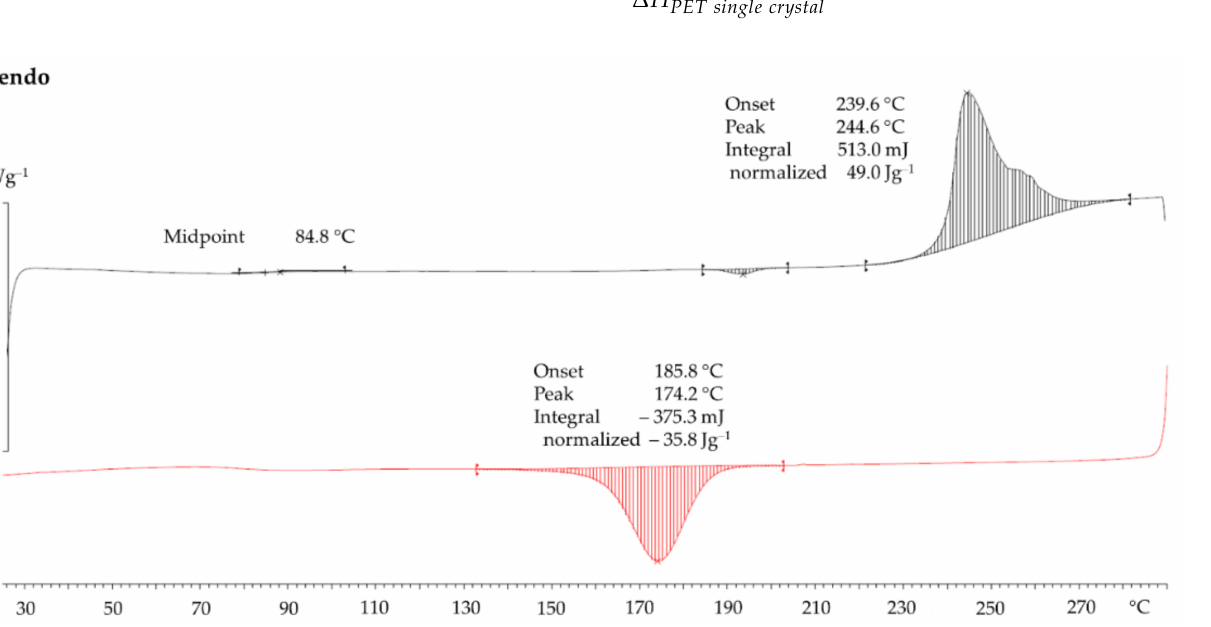
Figure 4. DSC of sieved PET powder and HSS PET bar. Top curve is melting (endothermic) and bottom curve is cooling (exothermic). The clear separation of the melting and crystallisation peaks in the powder is advantageous for PBF for controlling